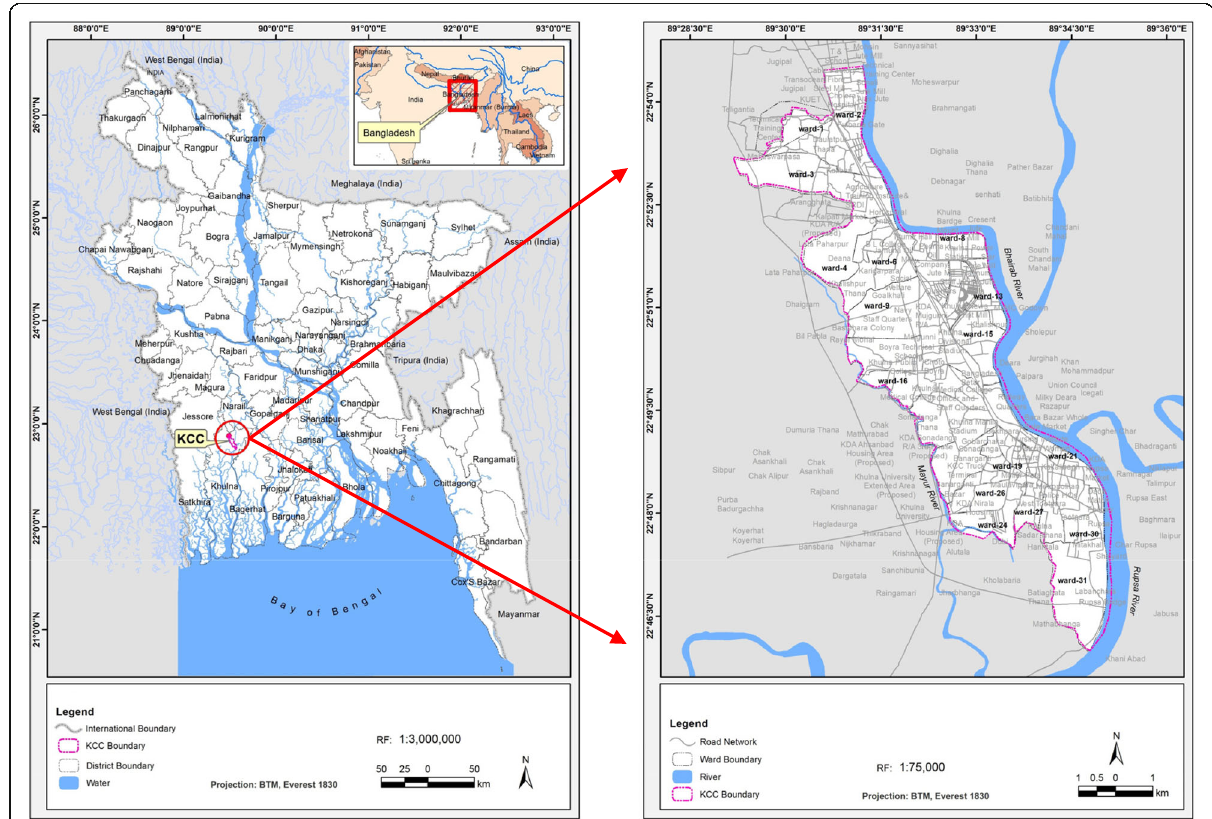
Fig. 1 Location of study area in context of